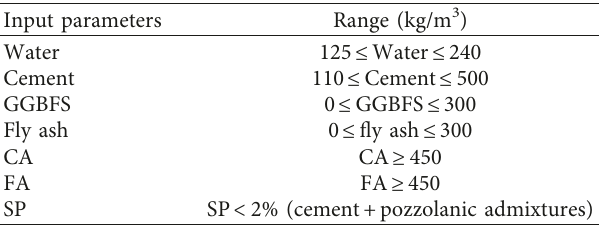
Table 1: Range of input parameters of CSPNN and SPNN in